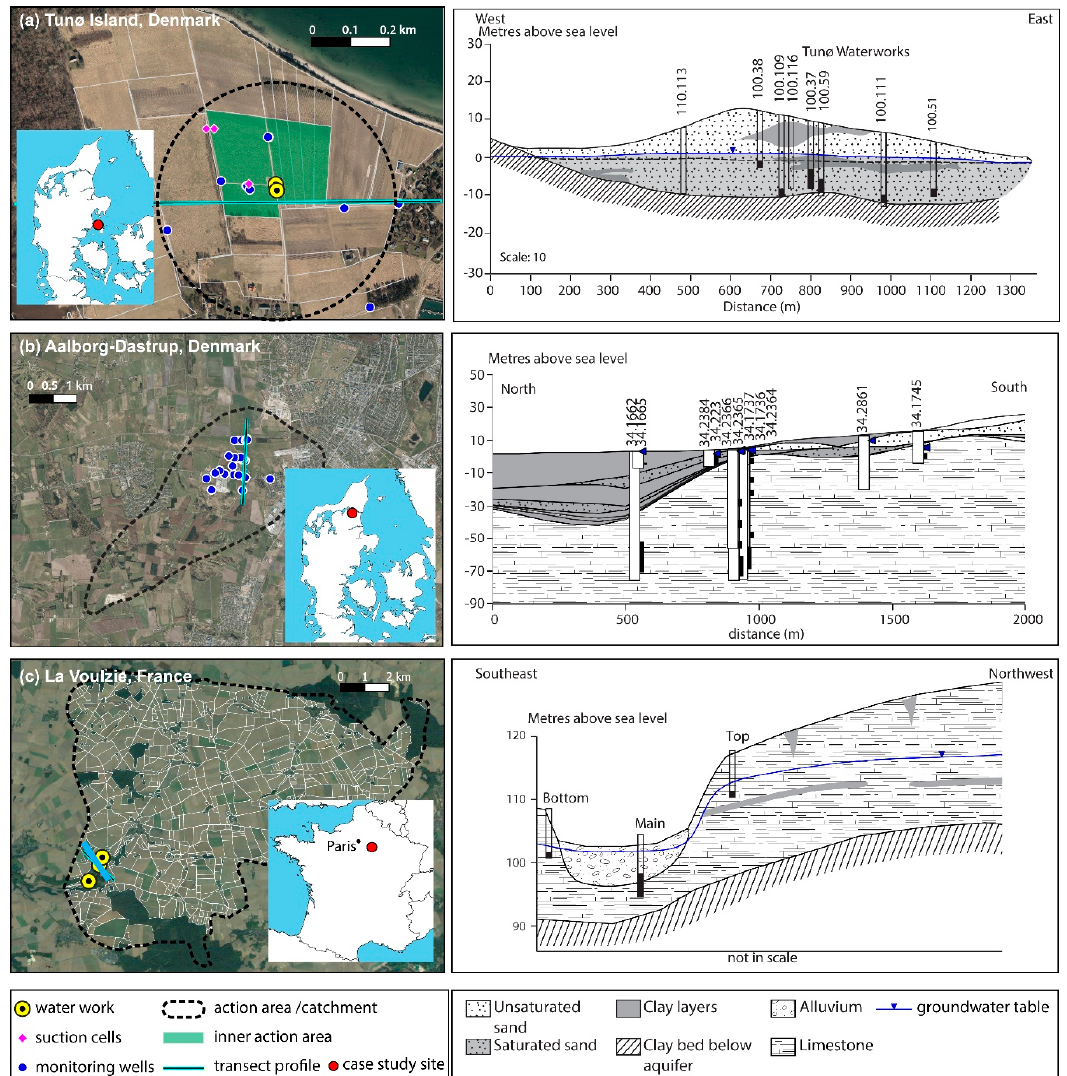
Figure 3. Maps of the three case study sites: Tunø Island, Denmark ( a ); Aalborg-Drastrup, Denmark ( b ); and La Voulzie, France ( c ).